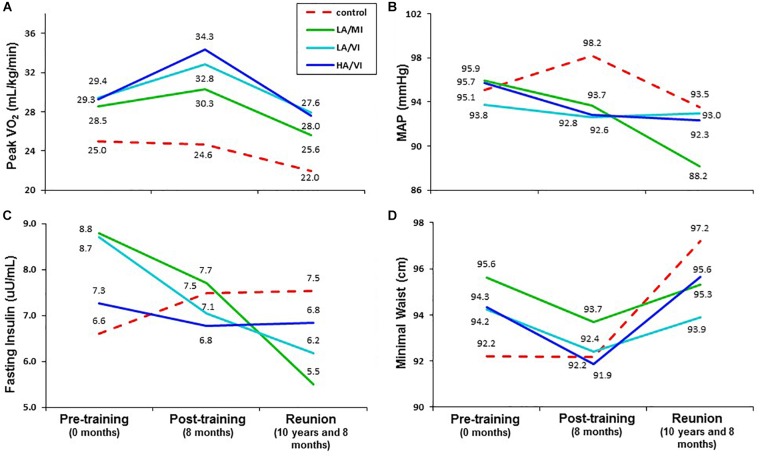
Mean values for pre-training ( 0 months), post-training (8 months) and STRRIDE Reunion (10 and 8 months) for peak VO2
(A), mean arterial blood pressure (MAP; B), fasting insulin (C), and minimal waist circumference (D). Dotted red line represents control group; solid green line represents low amount/moderate intensity group (LA/MI); solid light blue line represents the low amount/vigorous intensity group (LA/VI); and solid dark blue line represents the high amount/vigorous intensity group (HA/VI).